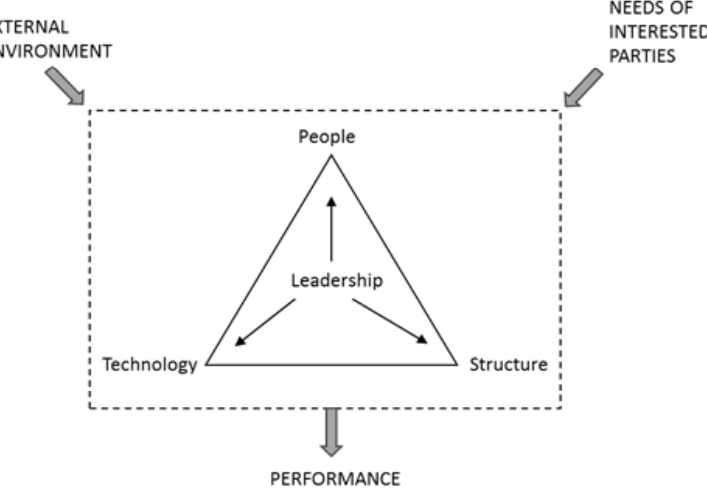
Figure 1. Elements influencing organizational performance.